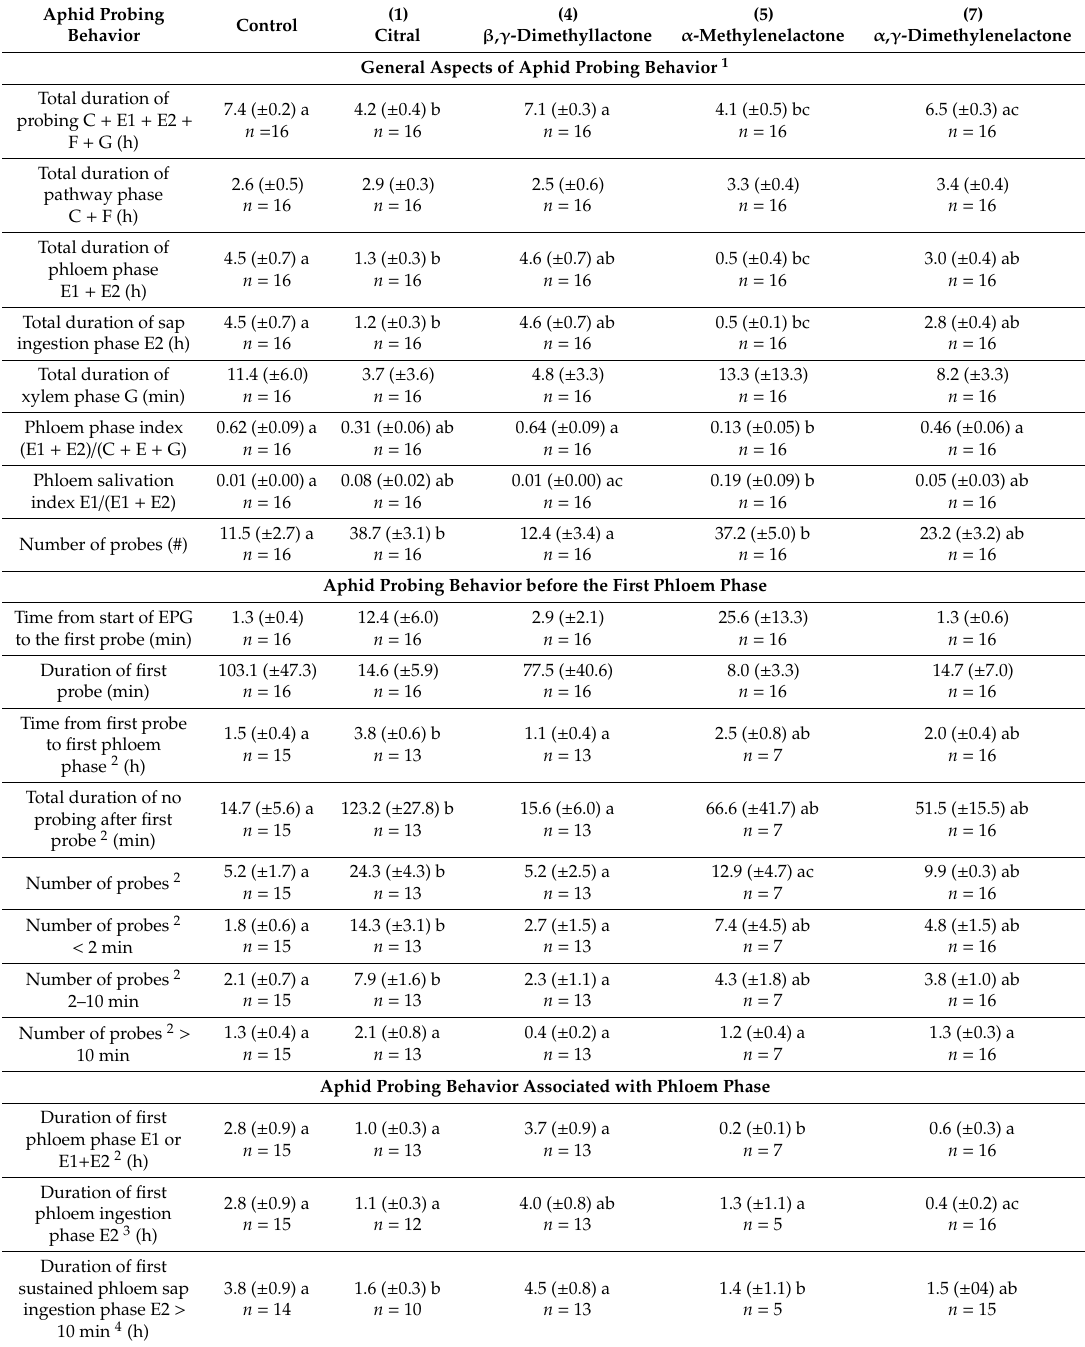
Table 3. Probing behavior of Myzus persicae on citral and citral-derived lactone-treated leaves (means ± SE). The mean and SE values are a representation of non-Gaussian data, but the statistical analysis was done by non-parametric tests in which all individual data were included; n = number of replications; C = pathway in non-phloem tissues; E1 = phloem salivation; E2 = phloem sap ingestion; F = derailed stylet activities; G = xylem sap ingestion. Di ff erent small letters in rows show significant di ff erences in the values of specific parameters among aphids on plants treated with individual citral derivatives (Kruskal–Wallis test, p <